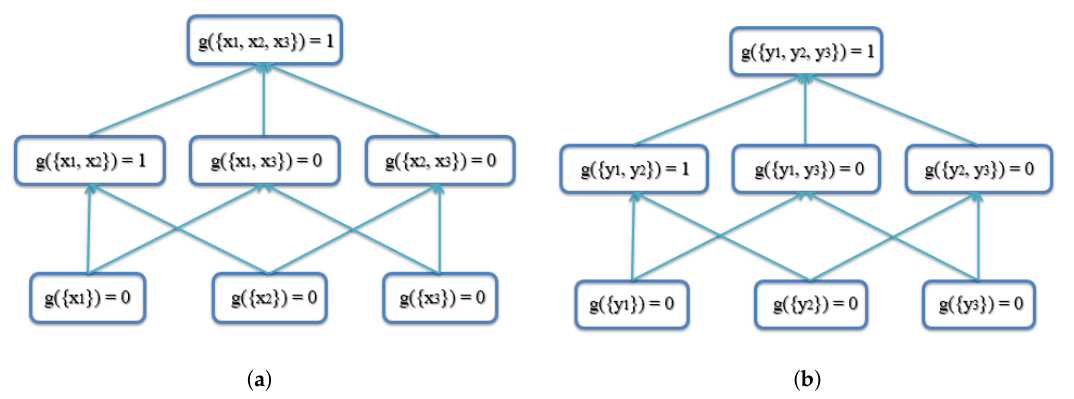
Figure 10. Lattice of the FM of agreement for the third example of three AABBs with one extreme outlier. ( a ) Lattice of the FM of agreement on the x-axis for the third example; ( b ) lattice of the FM of agreement on the y-axis for the third